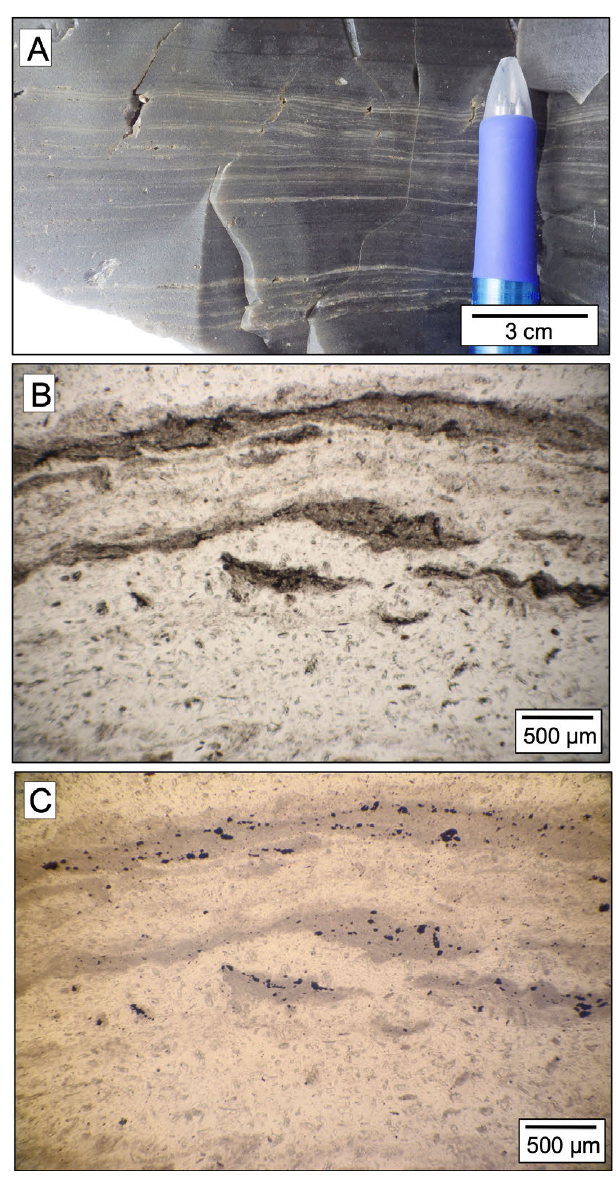
Figure 4: [A] Obsidian characterized by the well- developed flow banding defined by the difference in vesicularity. [B] Plane-polarized photomicrograph show- ing the flow banding. The black bands correspond to the light-colored bands in the outcrop. [C] Reflected light photomicrograph of [B]. The black area indicates the cavity.